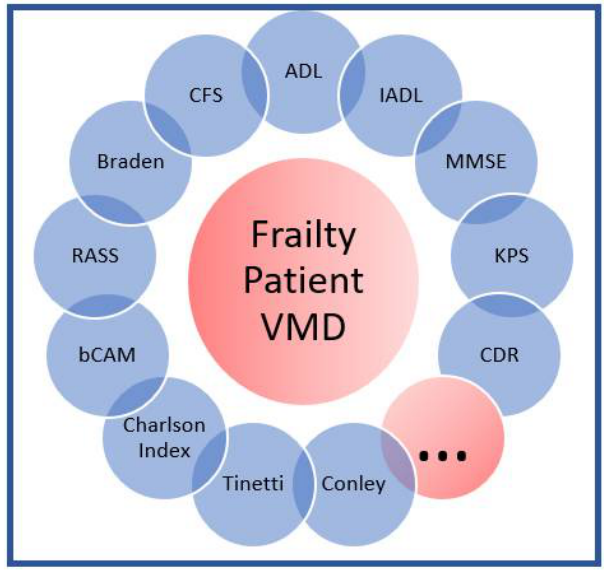
Figure 1. Multidimensional Evaluation.